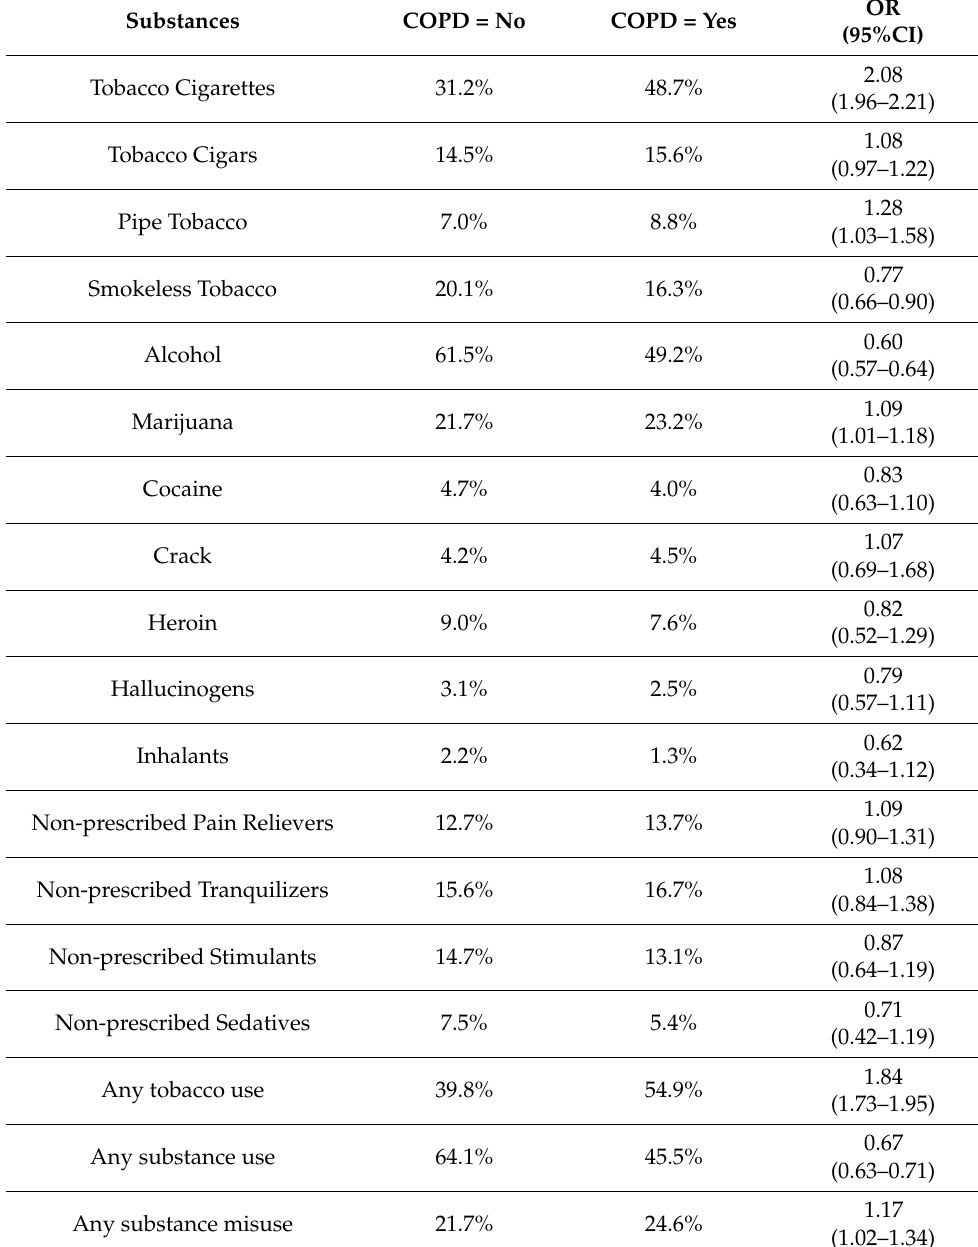
Table 2. Weighted prevalence of last-month substance use and misuse among adults with